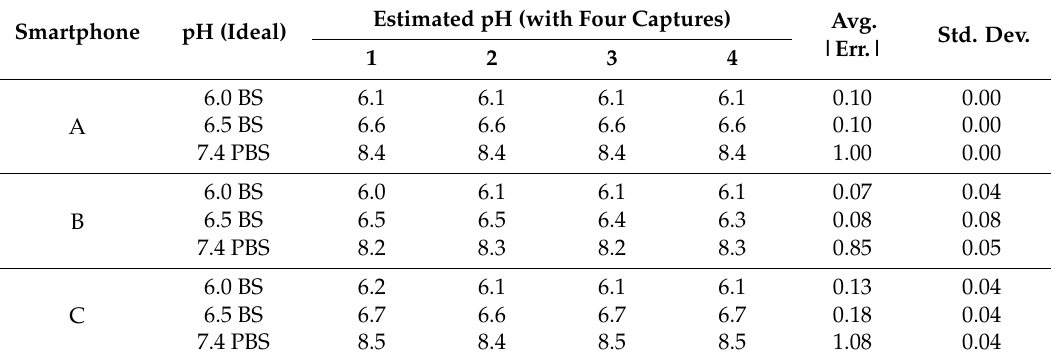
Table 2. pH estimation results for a few other BS and PBS samples. pH 6.0 BS (Ricca), pH 6.5 BS (EMS), and pH 7.4 PBS (Gibco) are